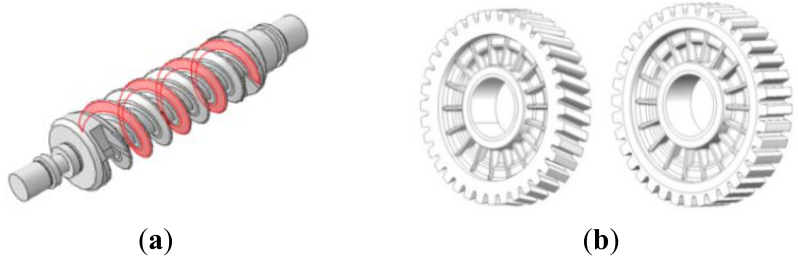
Figure 2. Design of worm and worm wheel: ( a ) worm; ( b ) worm wheel with helical and spur tooth